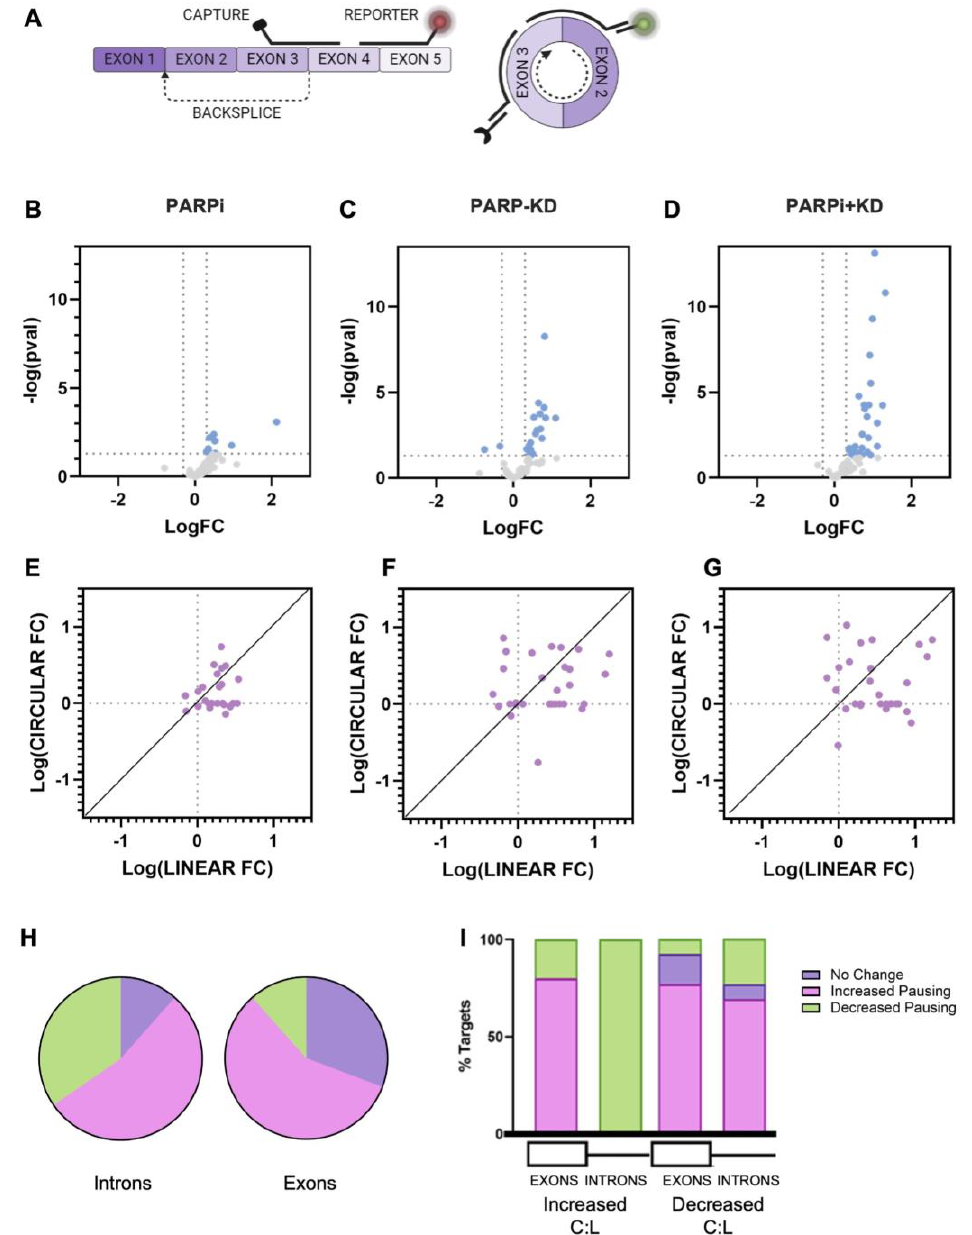
Figure 8. PARP1 fine tunes host gene transcriptional output through RNAPII pausing within host gene introns. ( A ) Schematic diagram of the NanoString codeset design. RNA transcripts are detected with complementary capture and reporter probes designed to hybridize the linear splice and circular backsplice junctions, respectively, for each host gene. Transcripts from ribosomal-depleted paired-end RNA-seq were counted via a unique fluorescent barcode assigned to each reporter probe. ( B – D ) Volcano plots showing the logFC of host gene expression due to PARPi ( B ), KD ( C ), and PARPi + KD combination treatment ( D ). Each dot represents either an mRNA or a circRNA transcript. Gray dots logFC < 2, p > 0.05; blue dots logFC > 2, p < 0.05. The log fold change of the circular transcripts was plotted against the log fold change of the linear mRNA for each host gene in PARPi ( E ), KD ( F ), and PARPi + KD combination treatment ( G ). ( H ) Pie charts showing the proportion of host genes with increased pausing (pink), decreased pausing (green), or no change in pausing (purple) within introns (left) or exons (right) upon KD. ( I ) Stacked bar graph showing the change in pausing within exons or introns of host genes. Host genes with increased circular to linear (C:L) ratio were compared to host genes with decreased C:L ratio.